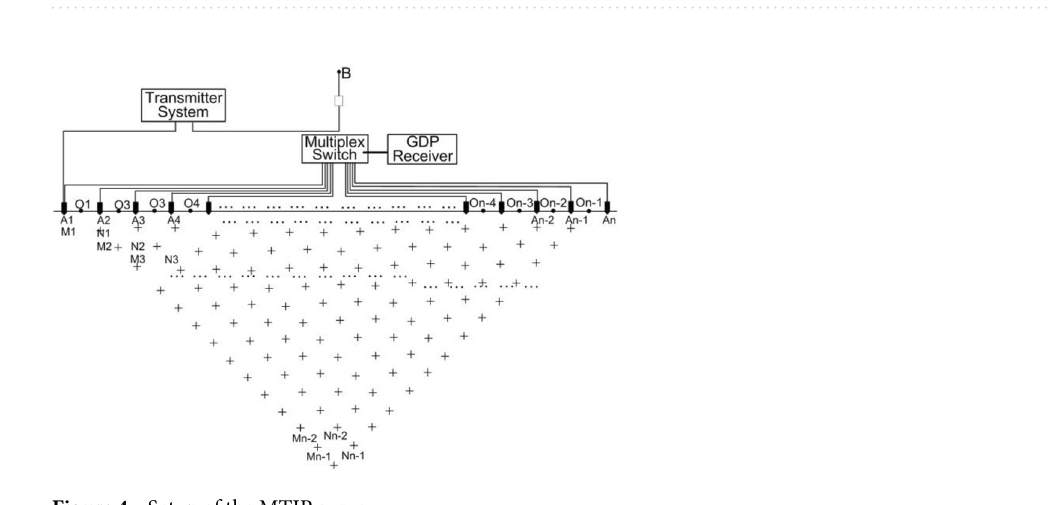
Figure 4. Setup of the MTIP